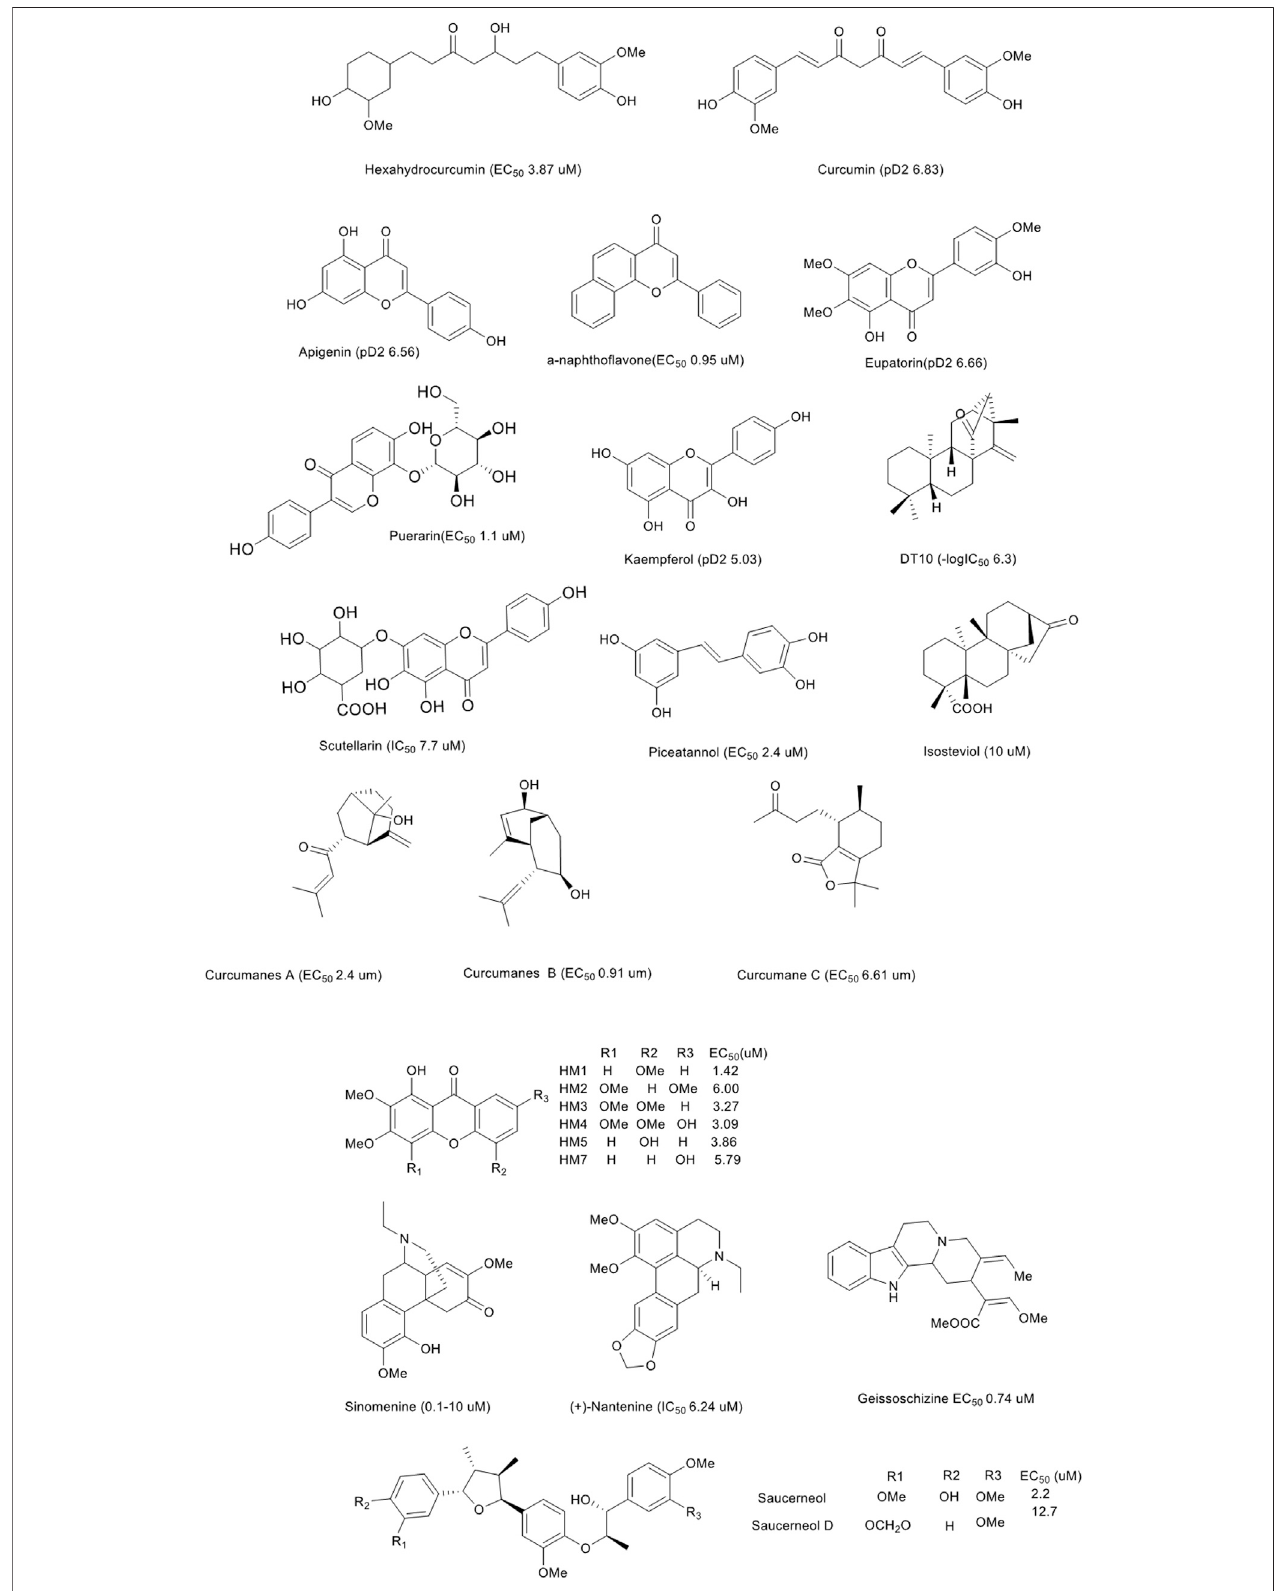
FIGURE 4 | Natural products with signi fi cant vasodilation effect.